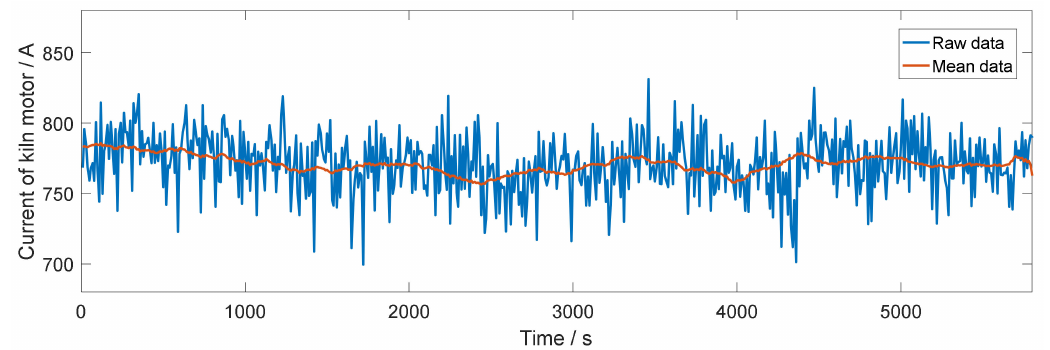
Figure 3. Current trend of kiln main motor.